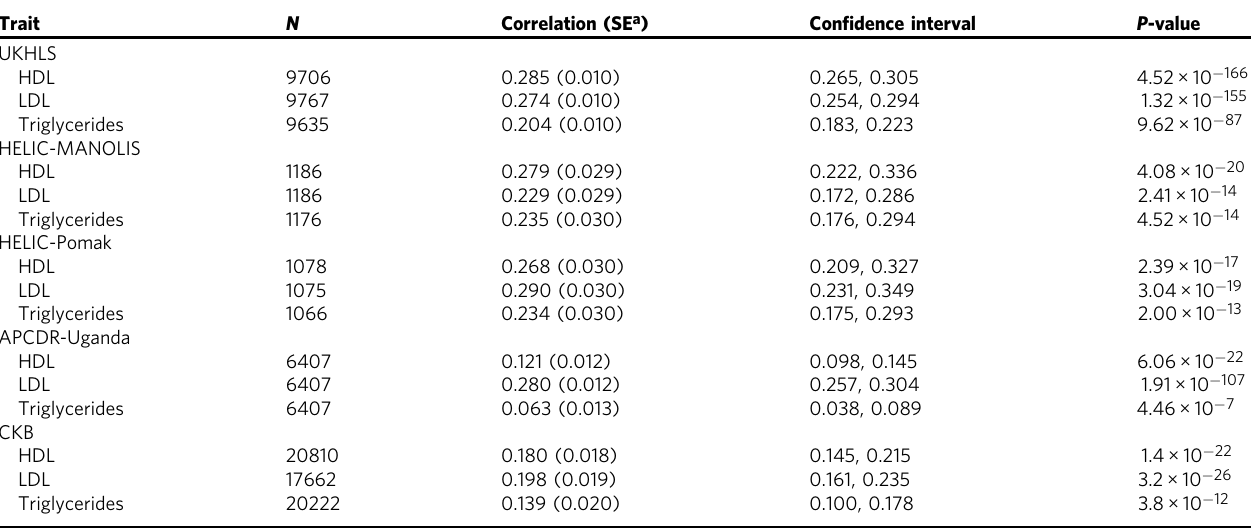
Table 2 Associations of genetic risk scores based on established lipid-associated loci and respective serum lipid levels in UKHLS, HELIC-MANOLIS, -Pomak, APCDR-Uganda, and CKB using a linear mixed model analysis